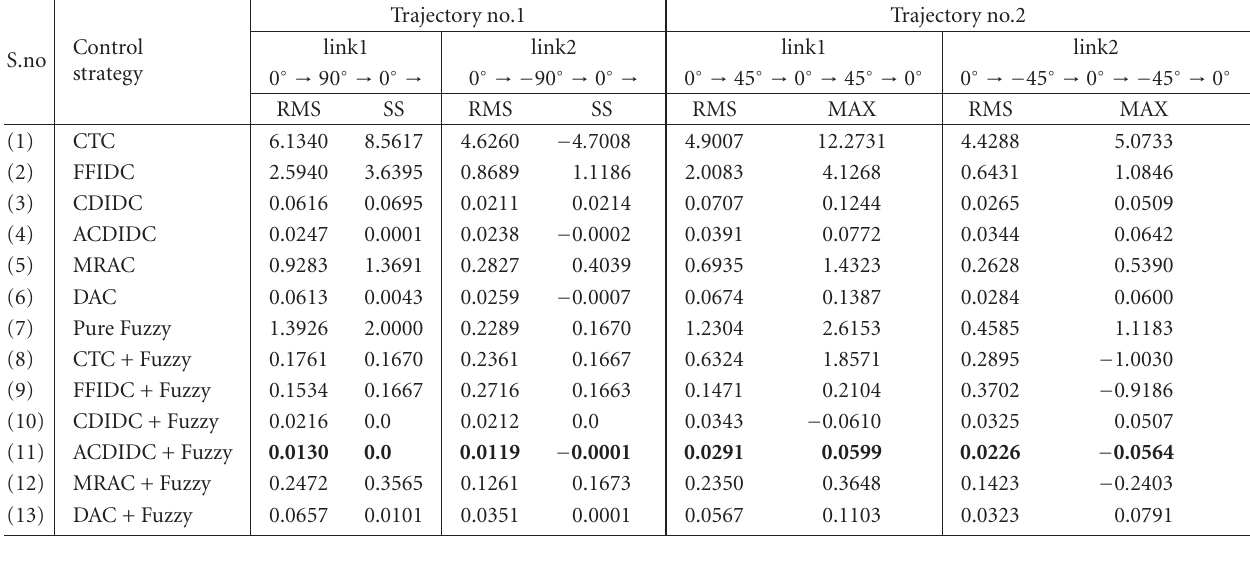
Table 2: Errors (in degrees) for di ff erent controllers.